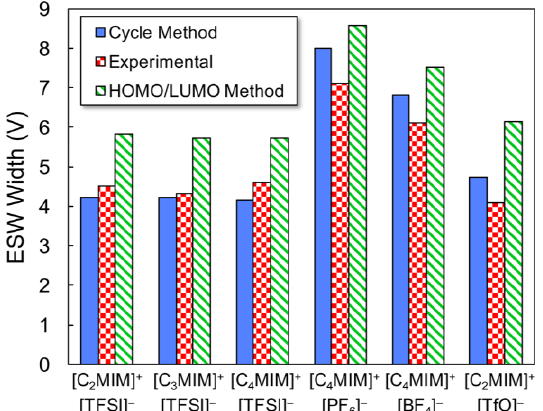
Figure 36. The calculated width of the electrochemical stability windows (ESWs) of select ionic liquids obtained by the thermodynamic cycle and highest occupied molecular orbital and lowest unoccupied molecular orbital (HOMO/LUMO) methods compared to the experimental values [60]. Adapted with copyright permission from Kazemiabnavi et al. [58]. Copyright© 2016, American Chemical Society.